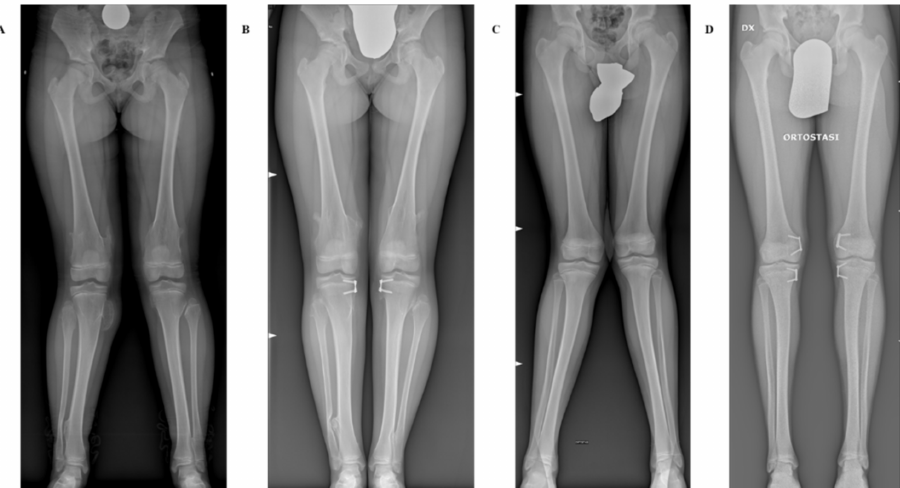
Figure 4. Long-standing anteroposterior radiographs showing two representative cases with and without MO undergoing hemiepiphyseal stapling (HeS). ( A , B ) Pre- and postoperative radiographs of a 13-year-old girl affected by genu valgum in MO treated by tibial HeS. ( C , D ) Pre- and postoperative radiographs of a 13-year-old boy affected by idiopathic genu valgum treated by combined femoral and tibial